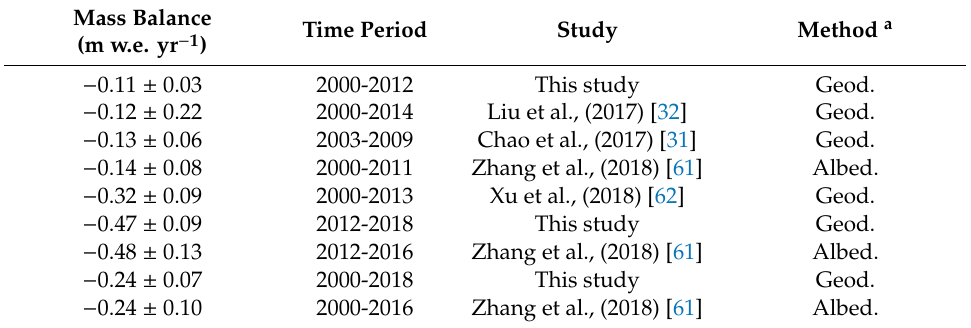
Table 3. Comparison with the estimates of glacier mass balances in previous studies over the GLDDM. Mass Balance Time Period Study Method a (m w.e. yr − 1 ) − 0.11 ± 0.03 2000-2012 This study Geod. − 0.12 ± 0.22 2000-2014 Liu et al., (2017) [32] Geod. − 0.13 ± 0.06 Chao et al., (2017) [31] Geod. − 0.14 ± 0.08 Zhang et al., (2018) [61] Albed. − 0.32 ± 0.09 Xu et al., (2018) [62] Geod. − 0.47 ± 0.09 This study Geod. − 0.48 ± 0.13 Zhang et al., (2018) [61] Albed. − 0.24 ± 0.07 This study Geod. − 0.24 ± 0.10 2000-2016 Zhang et al., (2018) [61]